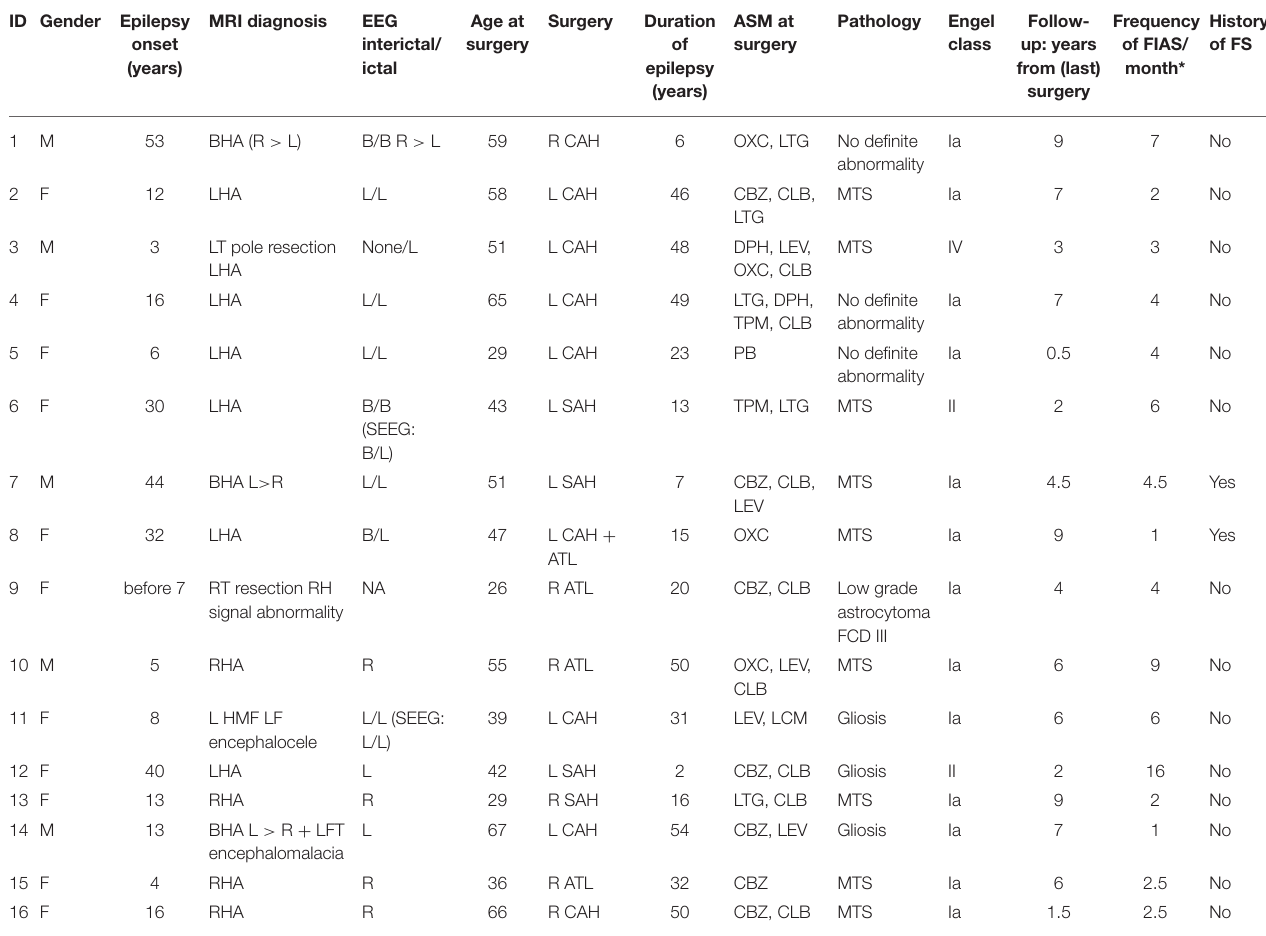
TABLE 1 | Patients clinical